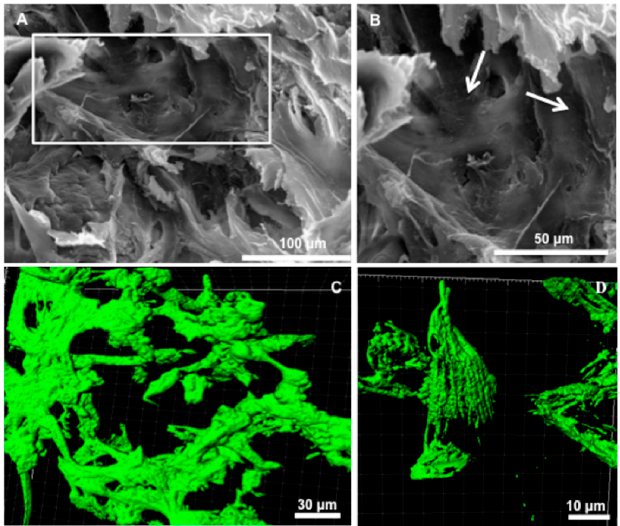
Figure 6. Cell morphology after 10 days of culture. ( A , B ) Over and closer (rectangle) scanning electron microscopy views (scale bars indicate 100 and 50 μ m, respectively), highlighting cell distribution within pores (white arrows); ( C , D ) Over and closer Imaris 3D views of cytoskeleton-labelled cells (scale bars indicate 30 and 10 μ m, respectively), showing actin bundles and highly-elongated cell morphology.